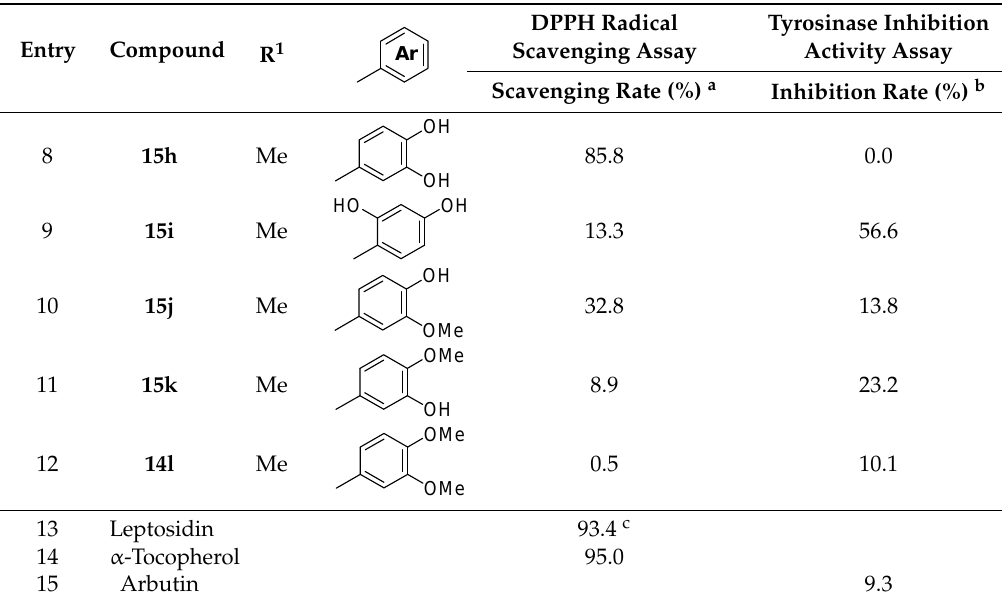
Table 4. The DPPH radical scavenging assay and tyrosinase inhibition activity assay of aurones 14l and 15a – k